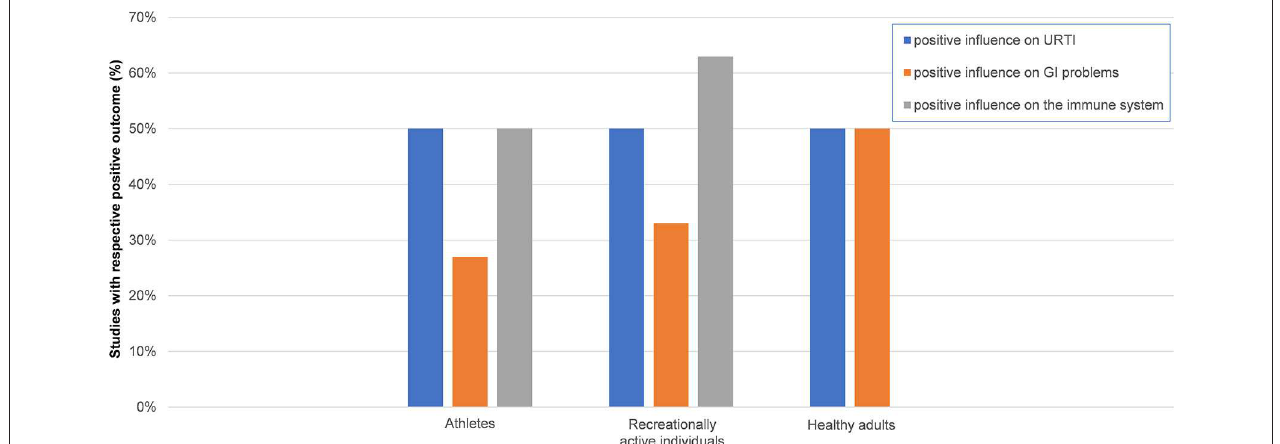
FIGURE 2 | Effect of probiotic supplementation on URTI, GI problems and the immune system by performance level. Columns illustrate the ratio of studies reporting positive effects on upper respiratory tract infections (URTI), gastrointestinal (GI) problems and the immune system. Results were based on the following number of studies. URTI in athletes, 5/10 studies; GI problems in athletes, 3/11 studies; immune system in athletes, 9/18 studies; URTI in recreationally active individuals, 2/4 studies; GI problems in recreationally active individuals, 1/3 studies; immune system in recreationally active individuals, 5/8 studies; URTI in healthy adults, 1/2 studies; GI problems in healthy adults, 1/2 studies; immune system in healthy adults, 0/5 studies. No influence was defined as non-significant change in outcome variables of URTI, GI problems or the immune system. GI problems were defined as incidence of symptoms and severity of nausea, vomiting, diarrhea, abdominal pain, abdominal bloating, flatulence, stomach “rumbles,” loss of appetite, and markers for GI barrier function (e.g., zonulin); URTI was defined as symptoms and severity of throat soreness, sneezing, fever, ear pain, blocked or runny nose, cough, duration, number of episodes based on author’s